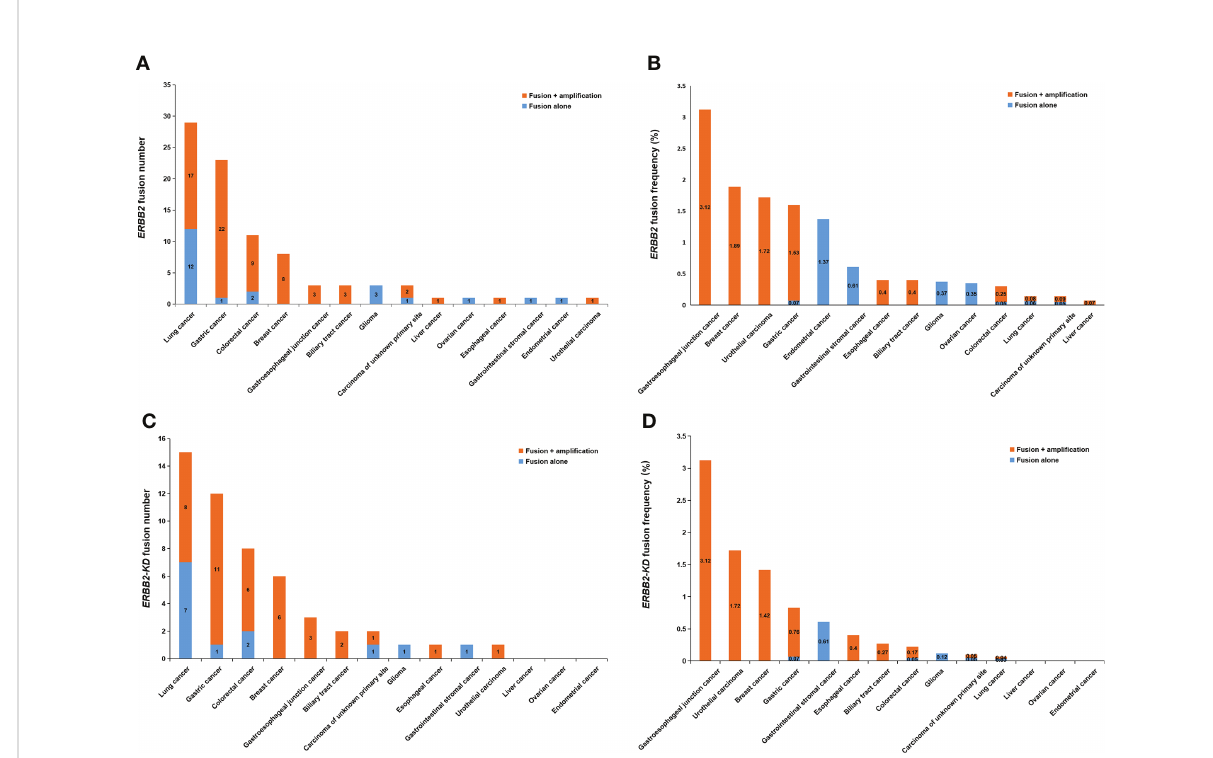
FIGURE 2 ERBB2 fusions in solid tumors. (A) The number of ERBB2 fusions in different cancer types. (B) The frequency of ERBB2 fusions in different cancer types. (C) The number of ERBB2-KD fusions in different cancer types. (D) The frequency of ERBB2-KD fusions in different cancer